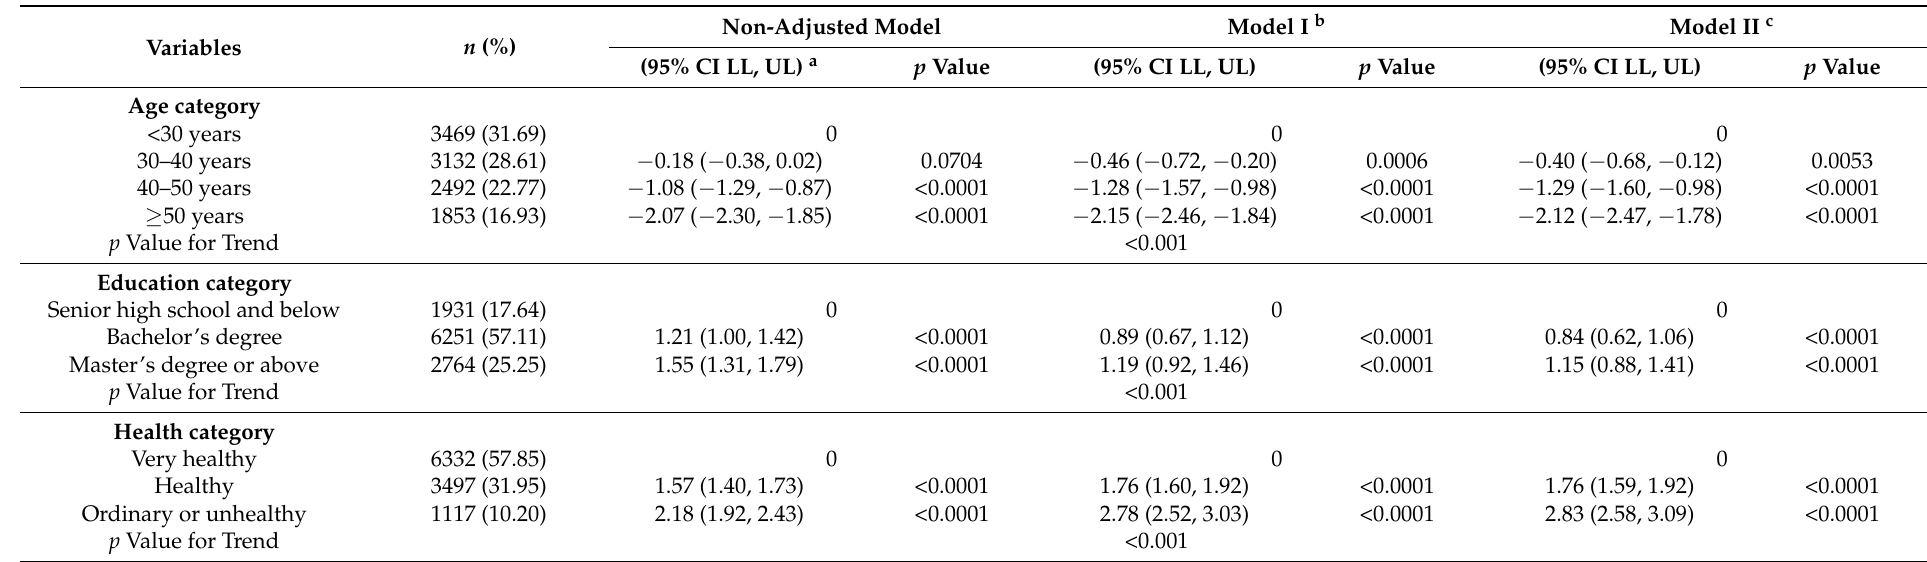
Table 2. The association of age, education, health, and anxiety score in the whole